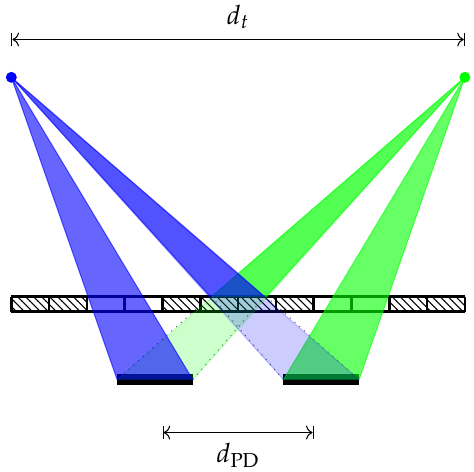
Figure 7. MIMO set-up using a single LCD for decorrelating two